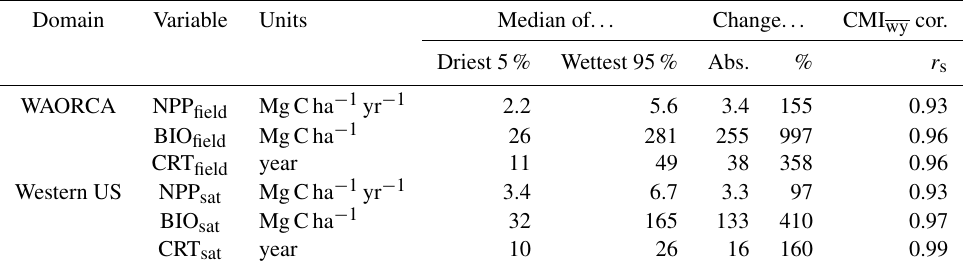
Figure 2. Tree net primary productivity (NPP, MgCha − 1 yr − 1 ) , live biomass (BIO, MgCha − 1 ) , and carbon residence time (CRT, years) increased with increasing water availability across both WAORCA (a–c) and the broader western US (d–f) . Forest characteristics were derived from field measurements at 1953 inventory plots in WAORCA (a–c) and from satellite remote sensing data sets across 18Mha of mature forest in the western US (d–f) . Tree NPP sat was characterized using MODIS data averaged annually from 2000 to 2014. Tree BIO sat was quantified based on an ensemble of aboveground biomass maps plus estimates of coarse-root, fine-root, and foliage biomass. Tree CRT was computed for each field plot and pixel as BIO/NPP. Water availability was quantified using a climate moisture index (CMI = P − ET 0 ) summed over the water year (October–September) and then averaged from 1985 to 2014 (CMI wy ) . The region was partitioned into 10cmyr − 1 (nonoverlapping) CMI wy bins, pixels and plots were allocated to bins, and then forest characteristics were summarized within each bin. In each panel, the bold line denotes the median, the dark gray band the 25–75th percentiles, and the light gray band the 10–90th percentiles. Note the different y axis scales between (b) and (e) , as well as (c) and (f) . Table 2. Changes in tree net primary productivity (NPP, MgCha − 1 yr − 1 ) , live biomass (BIO, MgCha − 1 ) , and carbon residence time (CRT, year) for stands over 100 years old along gradients in a climate moisture index (CMI wy , cmyr − 1 ) in both WAORCA and the broader western US. Forest characteristics were quantified using field measurements in WAORCA and satellite remote sensing data sets covering the western US. The analysis incorporated forests in areas where CMI wy was between − 200 and 200cmyr − 1 . Summaries include (1) median forest characteristics in the driest 5% and wettest 95% of pixels or plots, (2) the corresponding change, and (3) Spearman’s correlation ( r s ) between CMI wy and the median forest characteristics computed at 10cmyr − 1 CMI wy intervals. All correlations were statistically significant at α